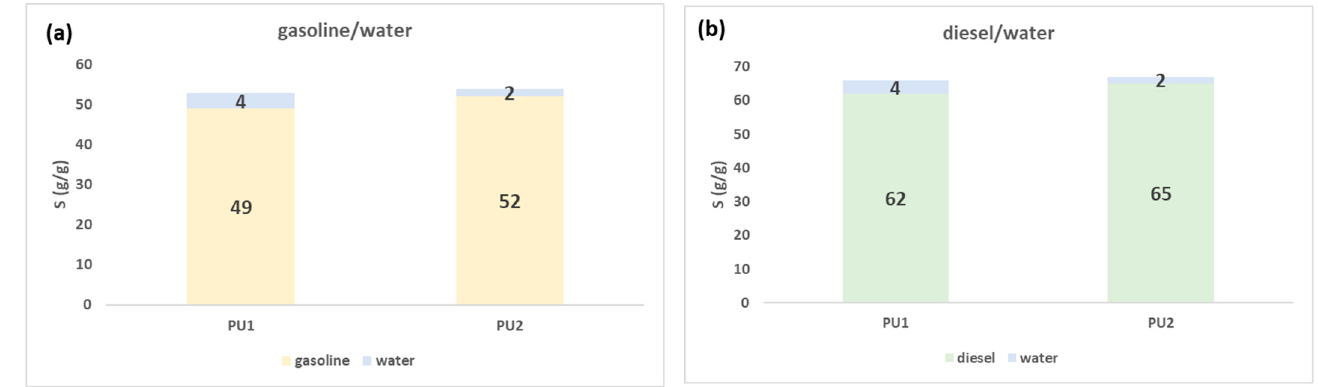
Figure 3. Total sorption capacity of PU1 and PU2 in gasoline/water ( a ) and diesel/water ( b ) starting from a solution of 80 g/L.